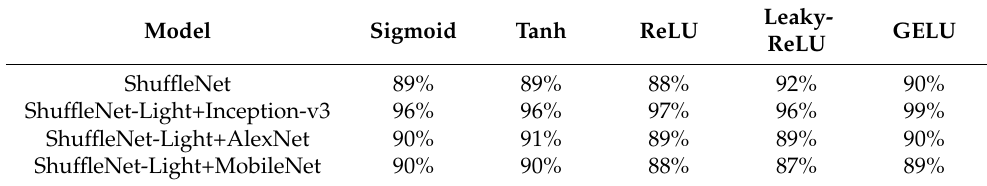
Table 13. Various activation functions compared in terms of accuracy measure. Model Sigmoid